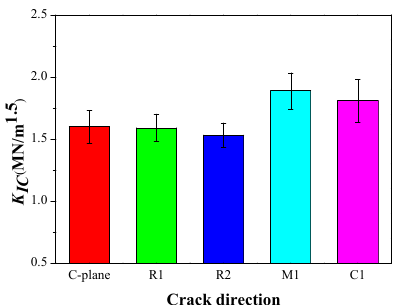
Figure 10. The fracture toughness ( K IC ) of C-plane sapphire and A-plane sapphire for different crack directions R1, R2, M1, and C1.